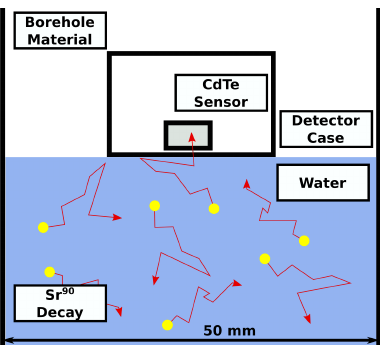
Figure 1. The simulation scenario illustrated. The detector is deployed to the surface of contaminated groundwater. Decaying radionuclides are randomly distributed throughout the